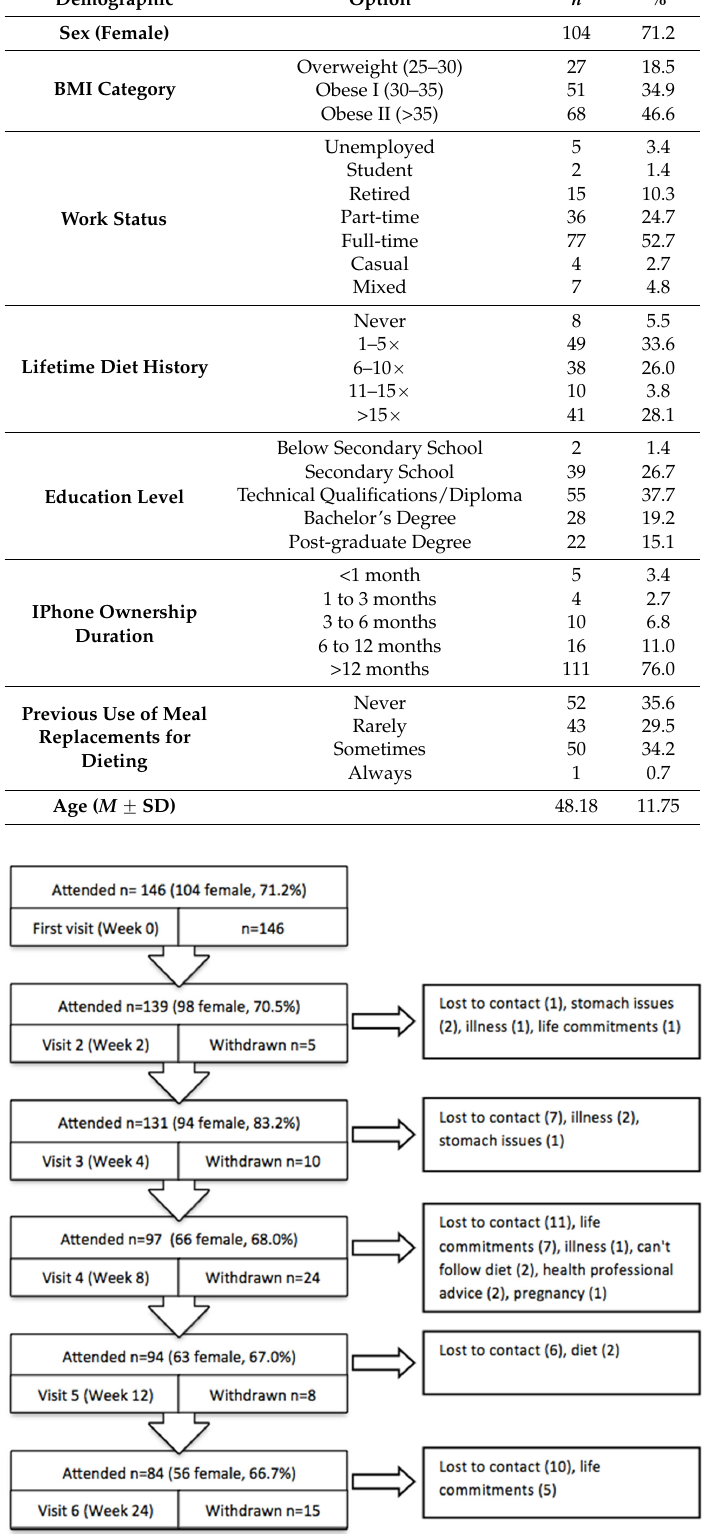
Figure 2. Study sample flow and withdrawals. Note: some people failed to attend on visit but did not withdraw from the study.